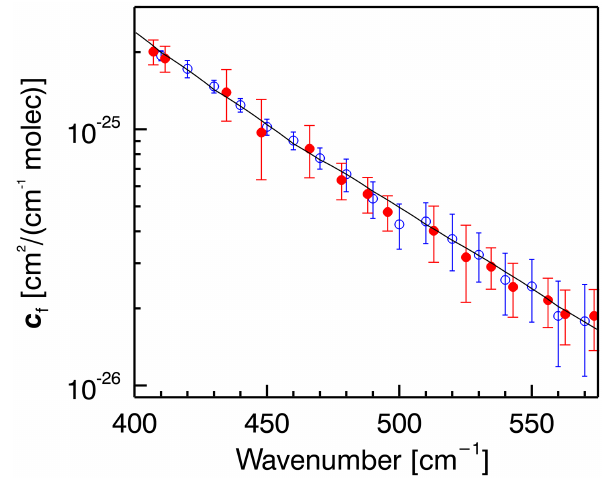
Figure 11. Mean foreign-continuum coefficients derived from the Zugspitze closure measurements (red) in comparison to the MT_CKD 2.5.2 model (black) and the results of Liuzzi et al. (2014) (blue).